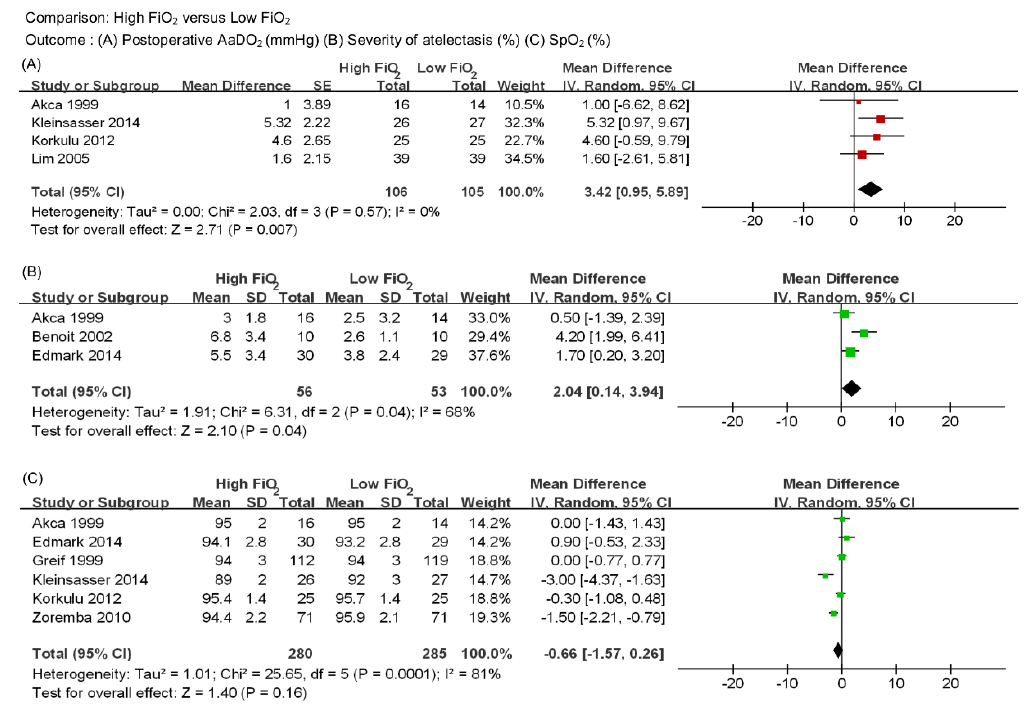
Figure 4. Forest plot for ( A ) postoperative AaDO 2 (mmHg), ( B ) severity of atelectasis (%), ( C ) postoperative SpO 2 (%).